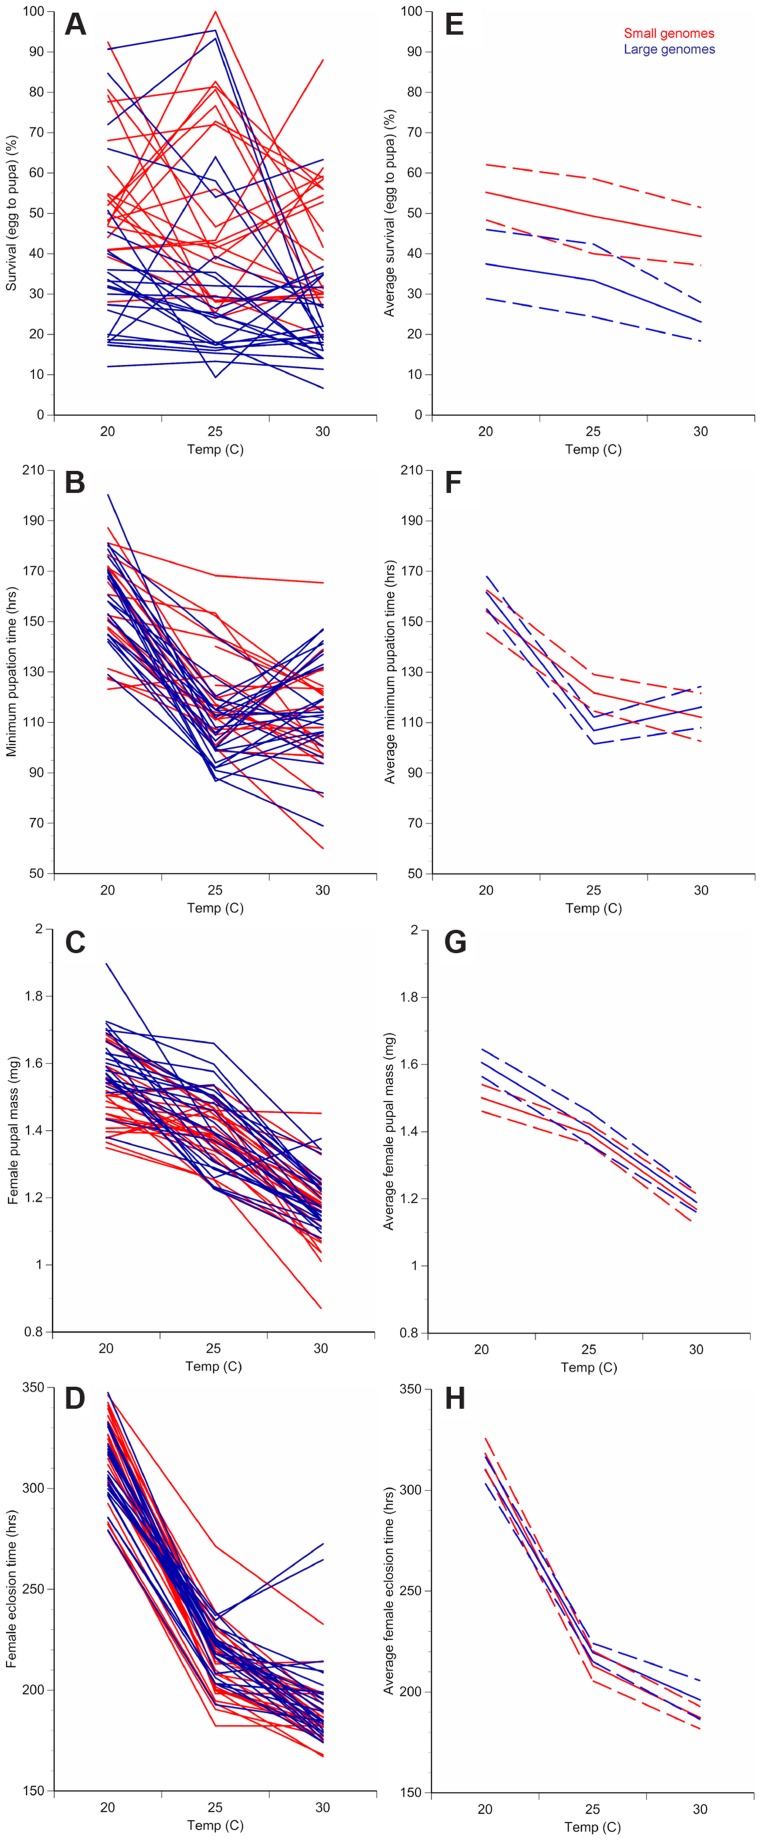
Changes in temperature alter development of D. melanogaster with small or large genomes.For each of the 25 small genome strains (red) and the 25 large genome strains (blue), the average survival to pupation (A), minimum pupation time (B), female pupal mass (C), and female eclosion time (D) was measured at 20°C, 25°C, and 30°C. Averaging the small genome strains (red) or the large genome strains (blue) for each phenotype shows temperature- and genome-size specific effects on survival to pupation (E), minimum pupation time (F), female pupal mass (G), and female eclosion (H). Increased genome size is associated with decreased survival to pupation (A, E) and increased female pupal mass (C, G). Dashed lines represent 95% confidence intervals.